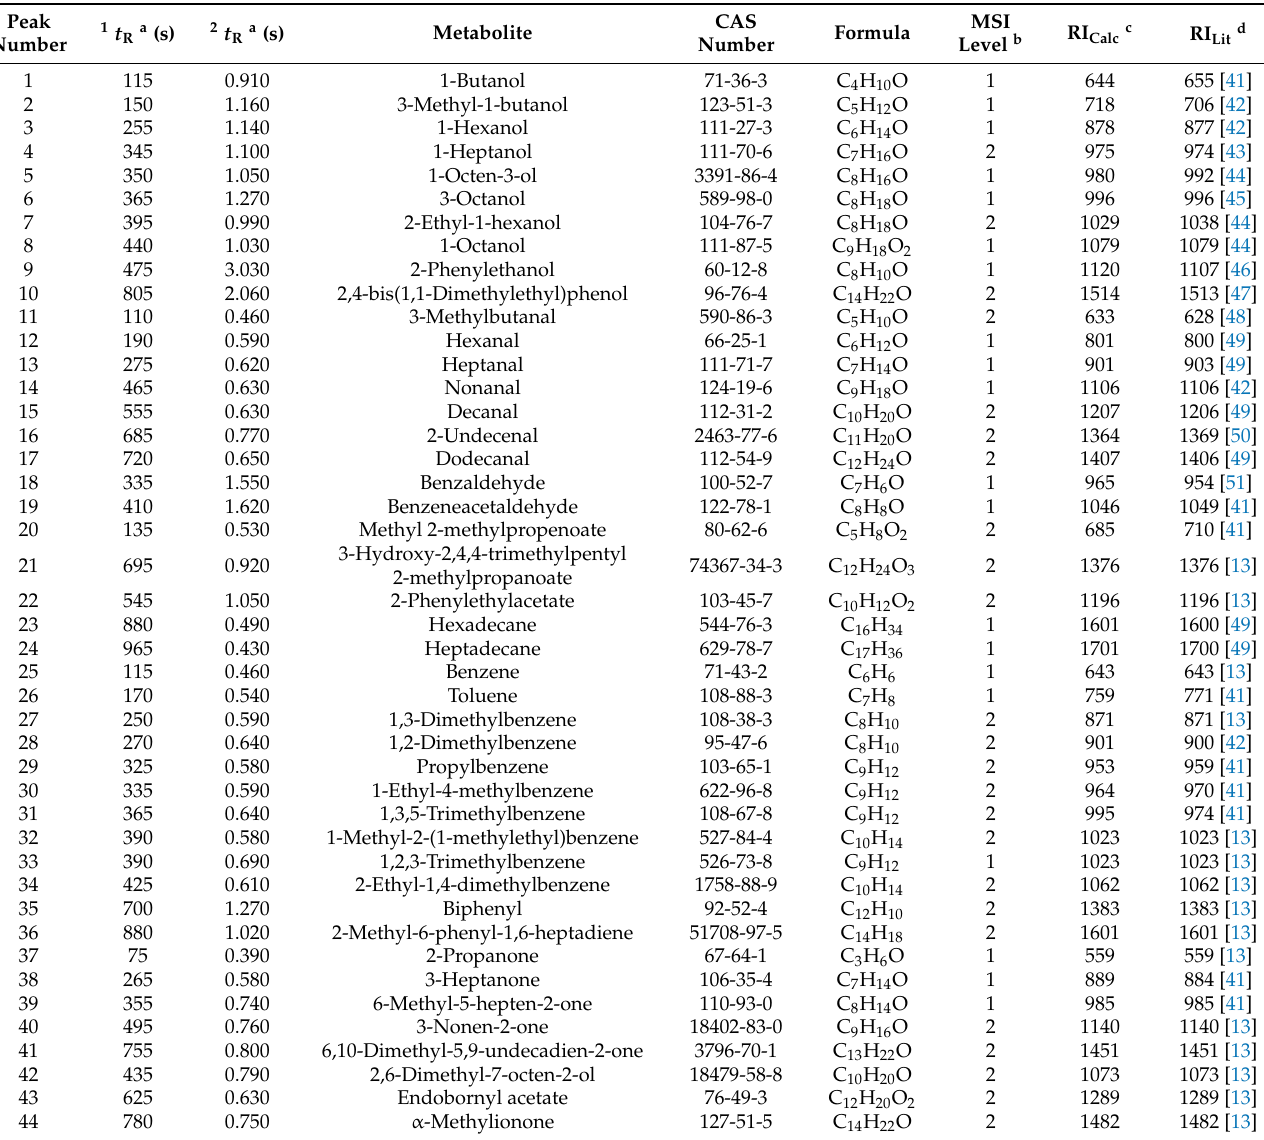
pattern [14] and determined by HS-SPME/GC × GC-ToFMS in the samples under study. The 44 metabolites set was chosen since they were identified in all the conditions studied for A. niger and, therefore, was defined as a standard of molecular biomarkers for this microor- ganism. This data set includes hydrocarbons, including aliphatic and aromatic (31.8%), alcohols (22.7%), aldehydes (20.5%), ketones (11.4%), esters (6.8%), terpenic compounds (4.6%), and norisoprenoids (2.3%). Table 1. List of the 44 metabolites named as the A. niger molecular biomarker pattern and determined by HS-SPME/ GC ×